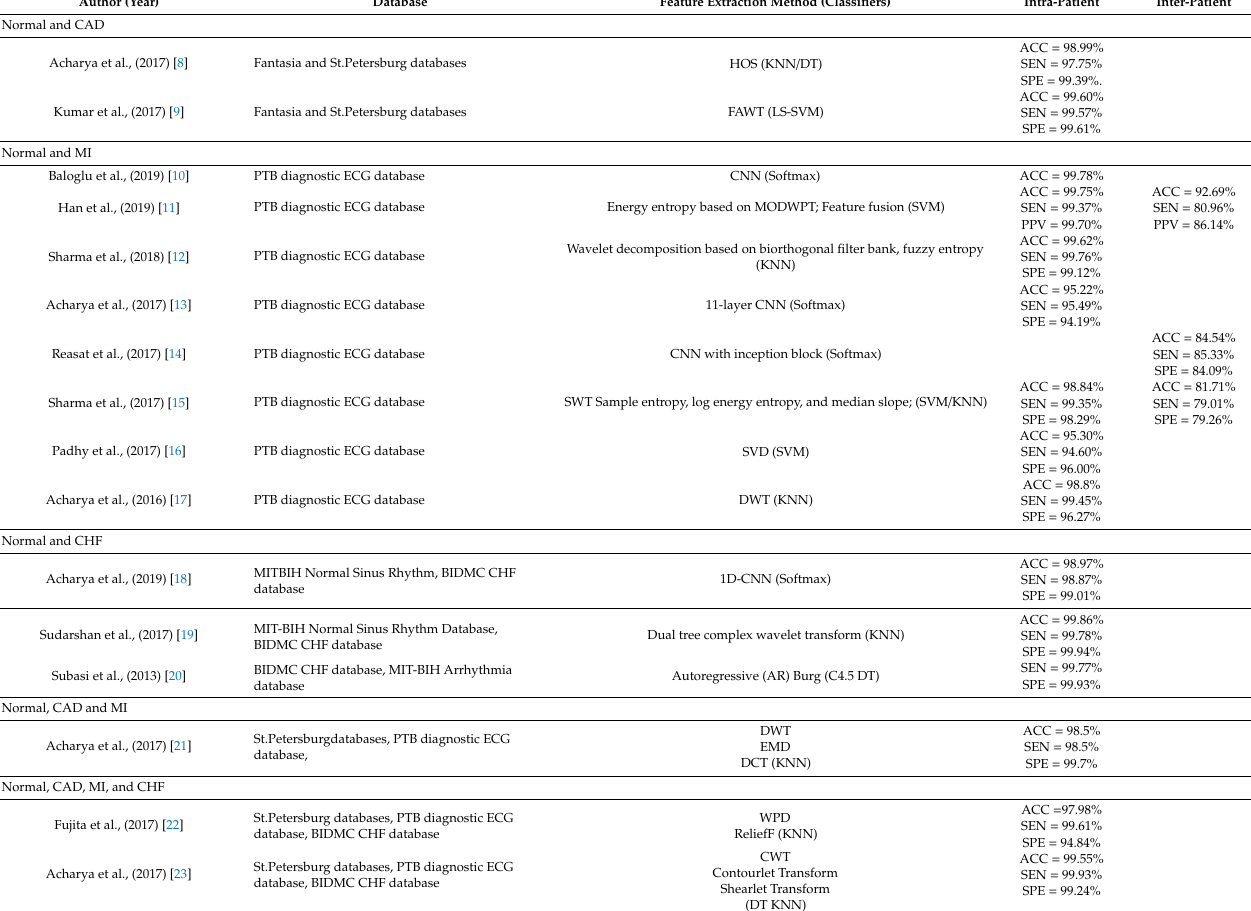
Table 1. Literature reviews using ECG for detection of normal, MI, CAD, and